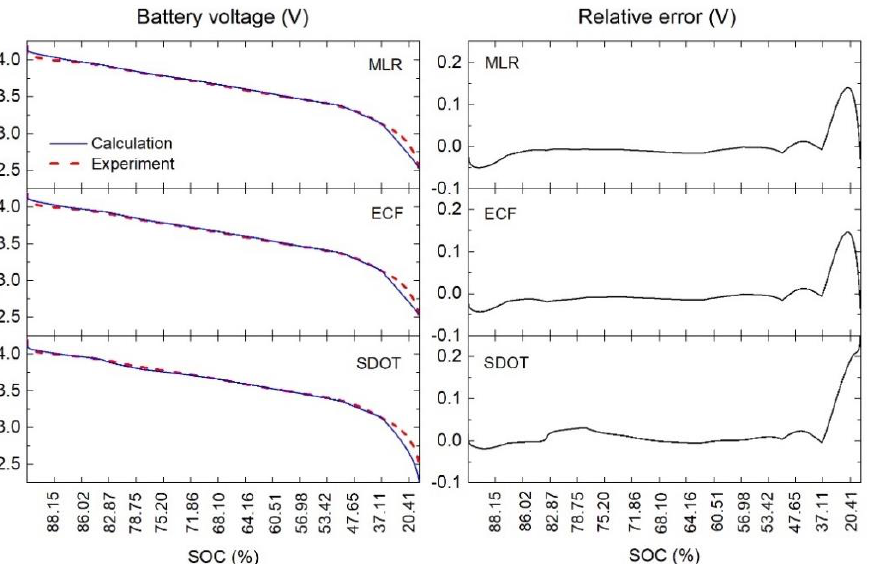
Figure 10. The battery terminal voltage of the pulse discharge test and the relative error for three estimations.